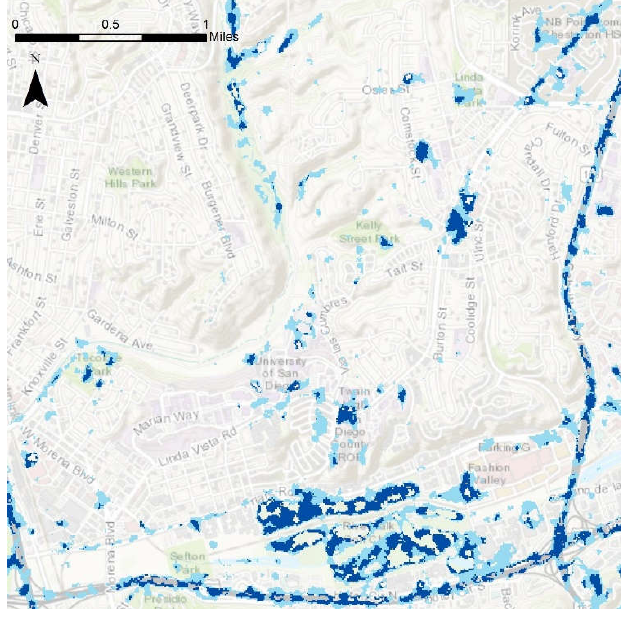
Figure 14. Fashion Valley Submap.